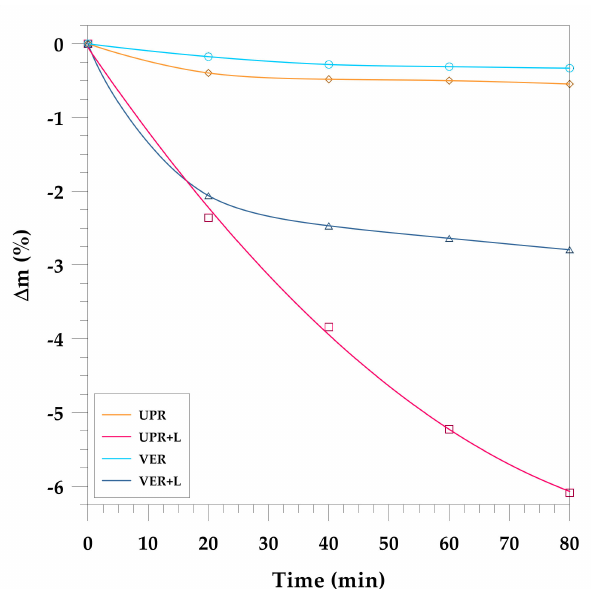
Figure 5. Mass change of the UPR and VER lignin-based composites during microwave